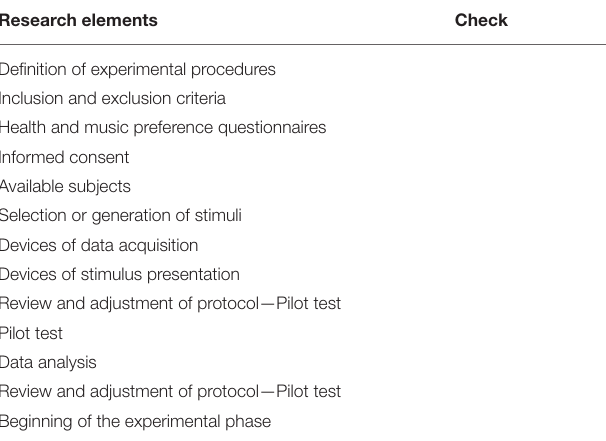
TABLE 5 | Checklist of research